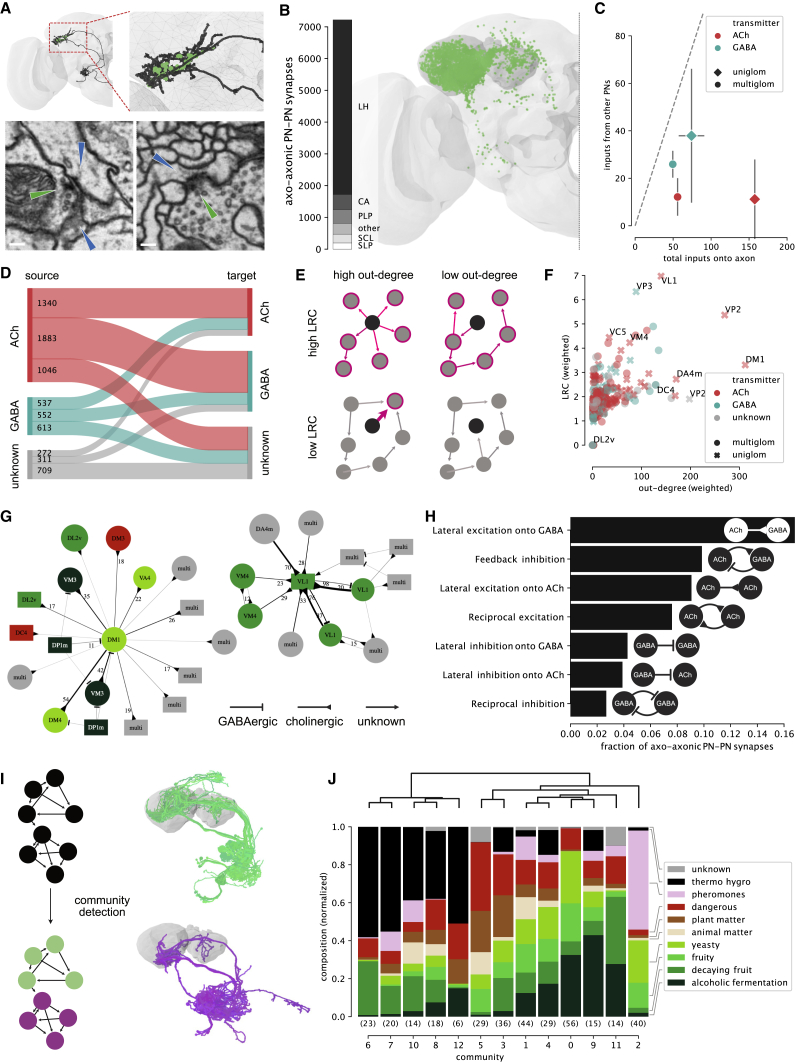
Axo-axonic Communities between Olfactory Projection Neurons(A) Axo-axonic synapses between olfactory PNs occur onto large backbones (lower left) and small twigs (lower right). Presynapses and corresponding postsynapses labeled with green and blue arrows, respectively; scale bar, 100 nm.(B) The majority of axo-axonic connections between PNs occur in the lateral horn.(C) Fraction of axonic inputs from other PNs. GABAergic PNs receive a higher fraction of inputs from other PNs than cholinergic PNs. Error bars represent SEM.(D) Flow chart visualizing axo-axonic connections between PNs by neurotransmitter.(E) Network analyses: nodes with high out-degree (many strong outgoing connections) are hubs in the network, nodes with high local reaching centrality (LRC) can potentially reach many nodes in the network (see STAR Methods for details).(F) Hierarchy analysis within the PN→PN network using LRC and out-degree. A few, mostly cholinergic uniglomerular PNs, represent major hubs in the network.(G) Graphs of two exemplary subnetworks around DM1 (left) and GABAergic VL1 (right) uPNs. Colors correspond to odor scene as in (J); numbers indicate synapses per unitary connection.(H) Quantification of motifs in axo-axonic PN-PN network. Arrowheads as in (G).(I) Community detection splits PN-PN network into 13 spatially overlapping communities (two examples shown).(J) Composition of communities by odor scene shows distinct preferences. Number of neurons per community given in brackets.See also Figure S3 and S7; Data S1, S2, and S3.